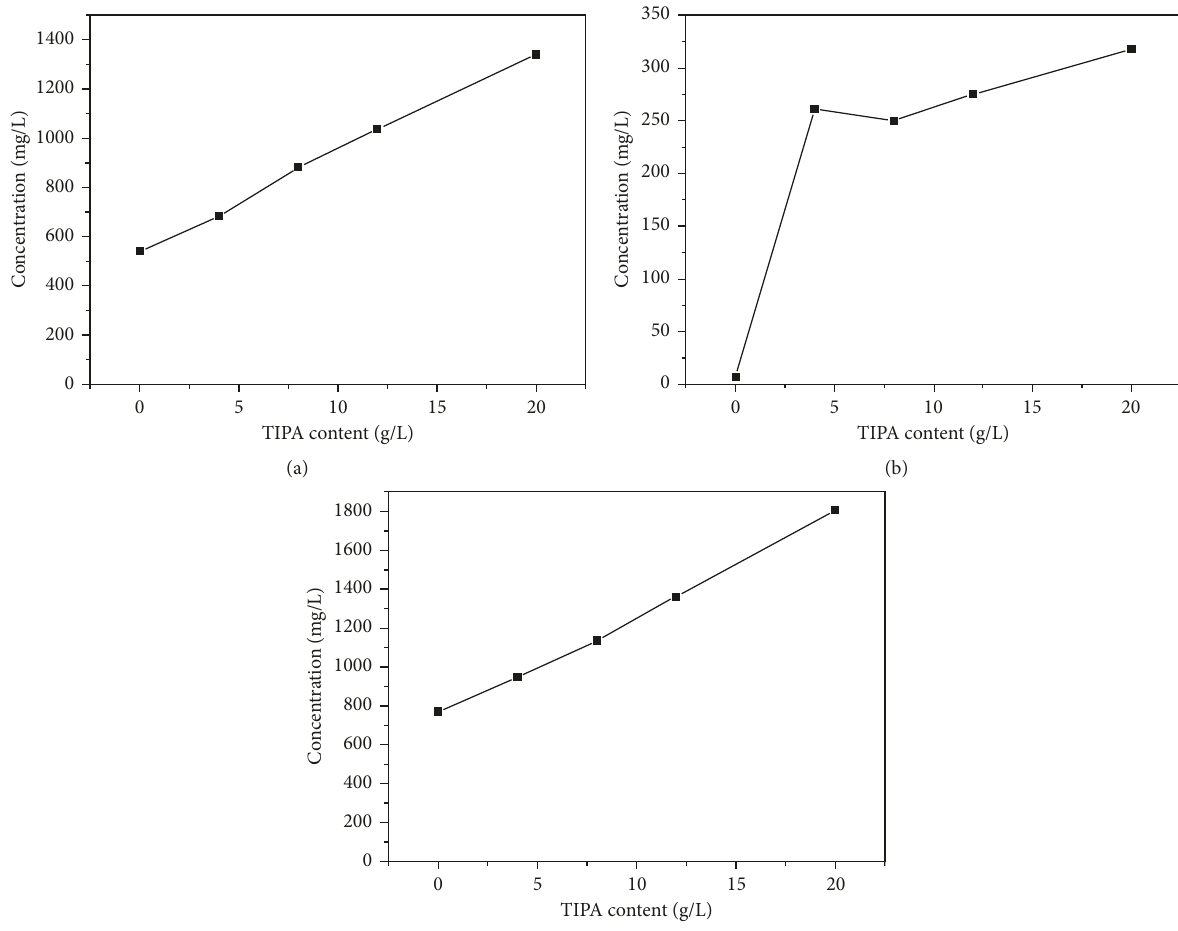
Figure 9: Ions dissolution of FA in the pore solution with TIPA at the age of 60 days. (a) Al; (b) Fe; (c) Si.